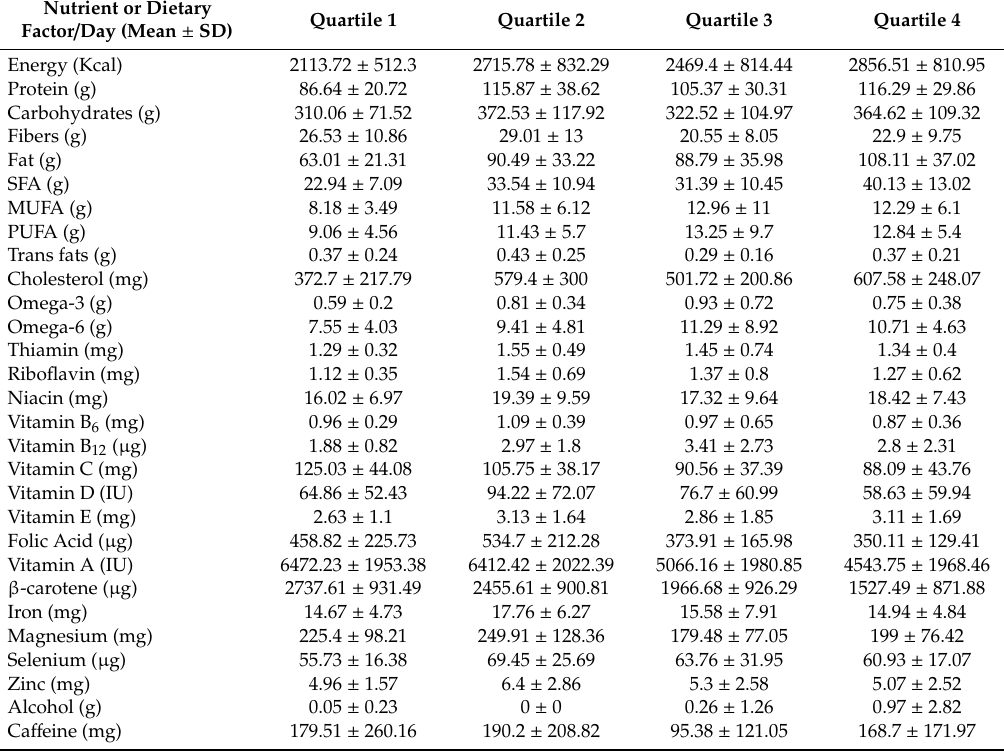
Table 3. Distribution of nutrients and dietary factors across quartiles of energy adjusted Dietary Inflammatory Index (E-DII) for schizophrenia cases.